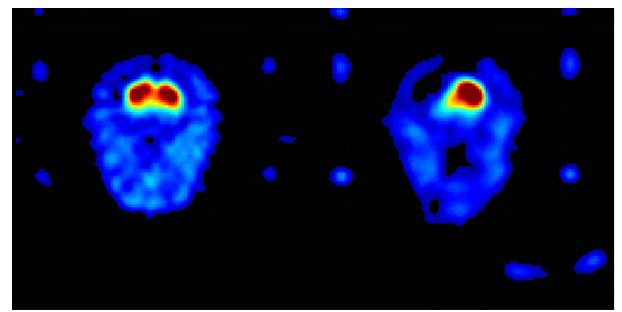
Figure 3. Monkey PET-FMT